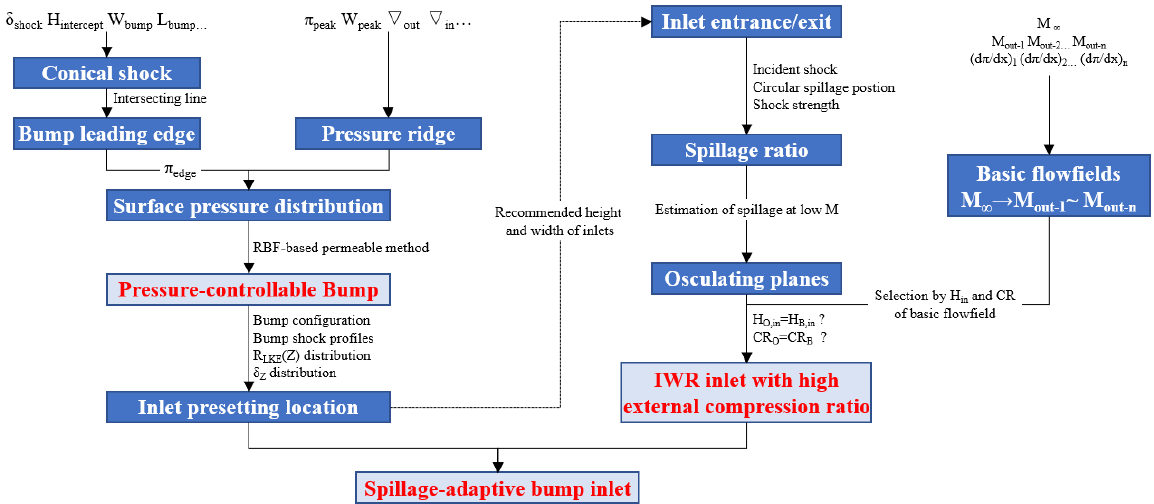
Figure 4. Schematic of the spillage ‐ adaptive bump ‐ inlet integration design. The design of the pressure ‐ controllable bump includes the leading edge and the sur ‐ face pressure distribution. The four design parameters of the bump leading edge are the cone ‐ shock angle δ shock , the intercepting height H intercept , the bump width W bump , and the bump length L bump . The δ shock is determined by the freestream speed and the derived cone angle, which can be calculated by the axisymmetric conical shock equations. The leading edge is obtained by the intersection of the conical shock wave and intercept plane. In this study, the planes parallel to xoy are taken as the intercept plane. The H intercept is the height between the intercepting plane and the central line. The W bump and L bump are two related parameters. Herein, the bump leading edge is uniquely determined when δ shock , H intercept , and W bump (or L bump ) are fixed.